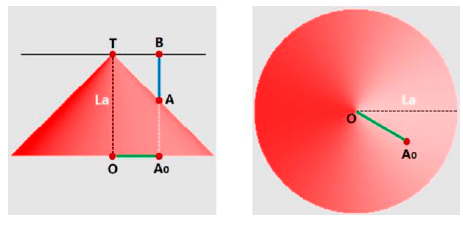
Figure 8. The size of the cones.